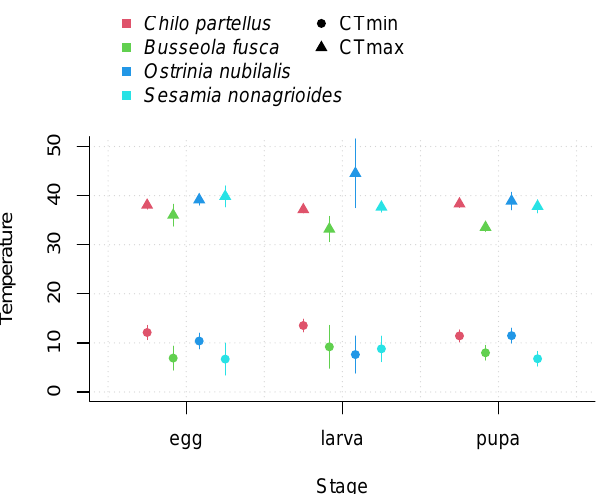
Figure 4. Estimated critical threshold values ( ± Standard Errors) for egg, larva and pupa stage of Chilo partellus , Busseola fusca , Ostrinia nubilalis , and Sesamia nonagrioides